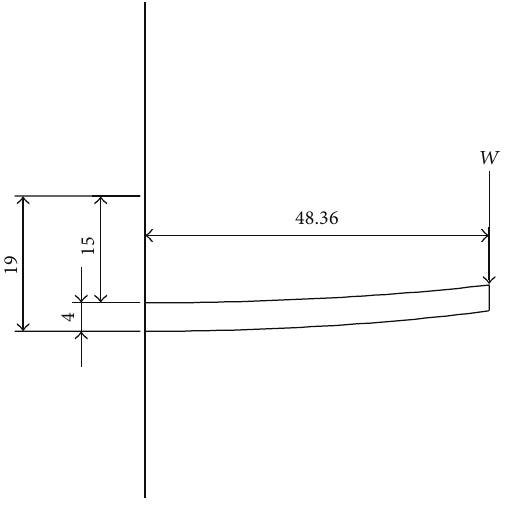
Figure 5: A half of an elliptic monoleaf spring.